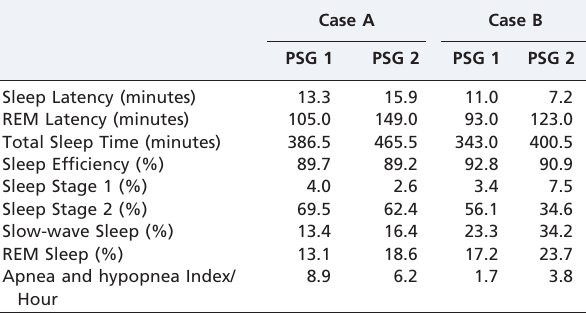
Table 1 - Objective sleep parameters prior to and following psychological treatment.